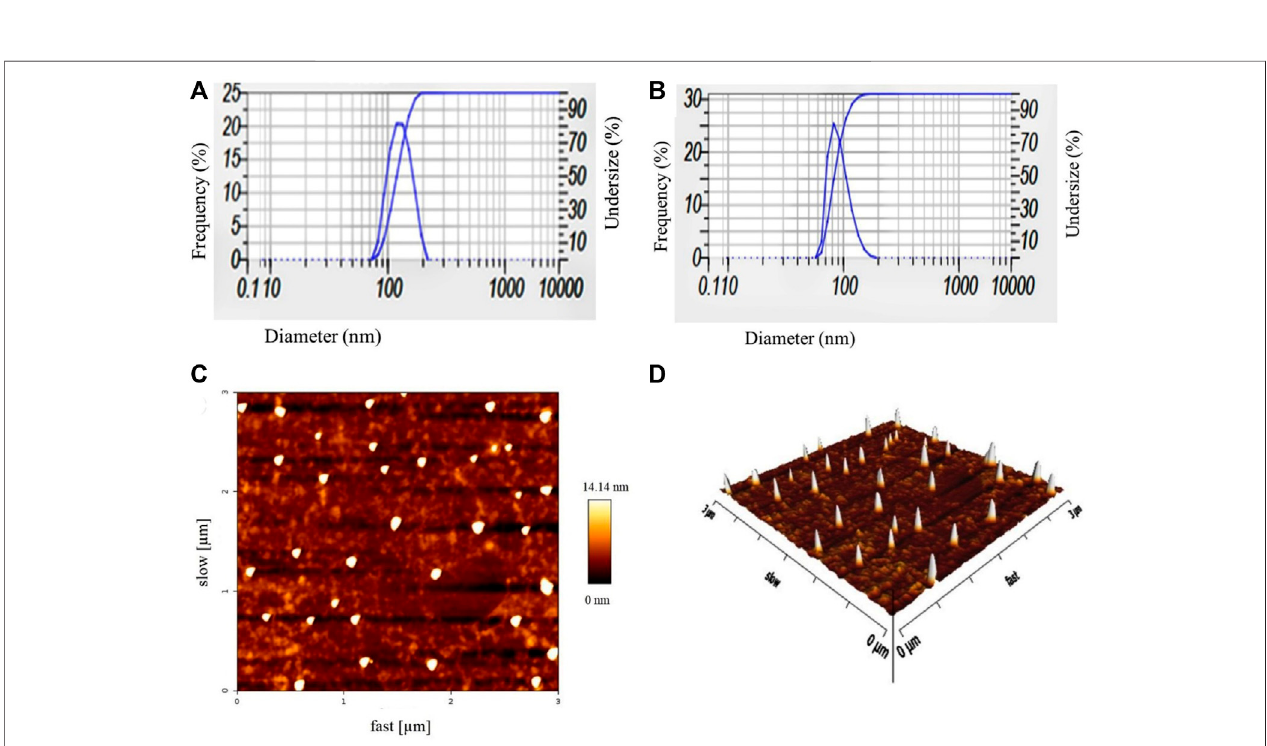
FIGURE 2 | Particle size distribution and zeta potential values of blank nanoniosomes (A) and Cur-Nio (B) . Two-dimensional (C) and three-dimensional (D) AFM images of Cur-Nio.